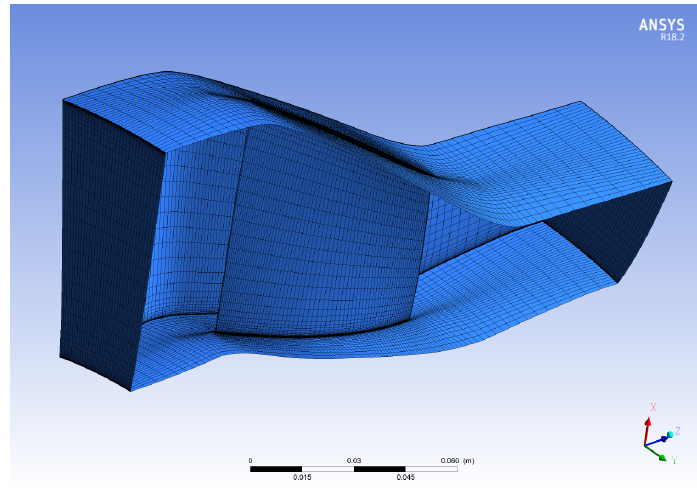
Figure 6. Computational domain.